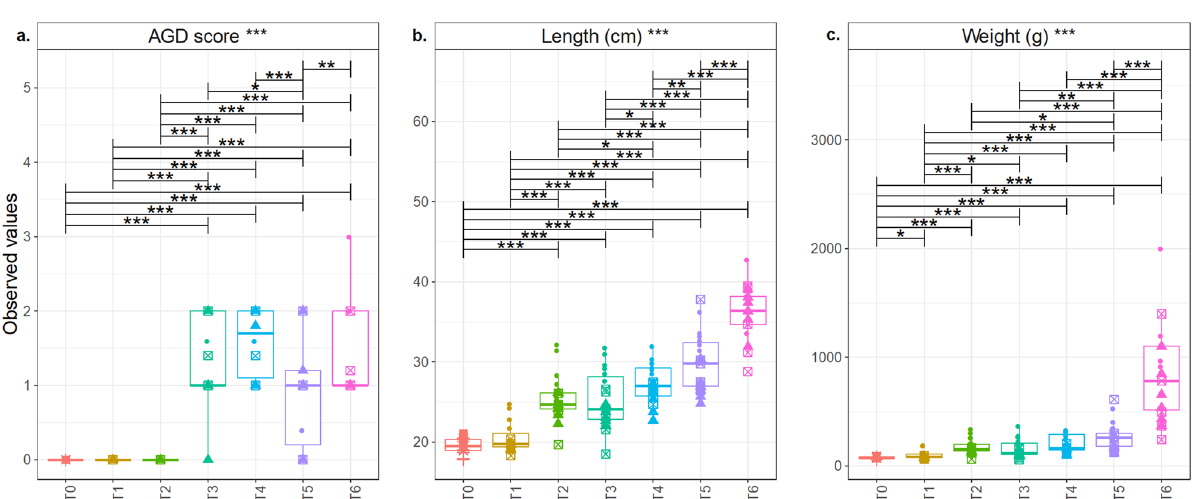
Figure 2. ANOVA of pair-wise comparison of extrinsic metadata considered in this study, and after applying appropriate normalization (where necessary). Lines connect two categories where the differences were significant with *( P < 0.05), **( P < 0.01), or ***( P < 0.001). Mean ( a ) Gill score, ( b ) length (cm), and ( c ) weight (g) at each of the timepoints. Figure titles with *** refer to analyses that included significant